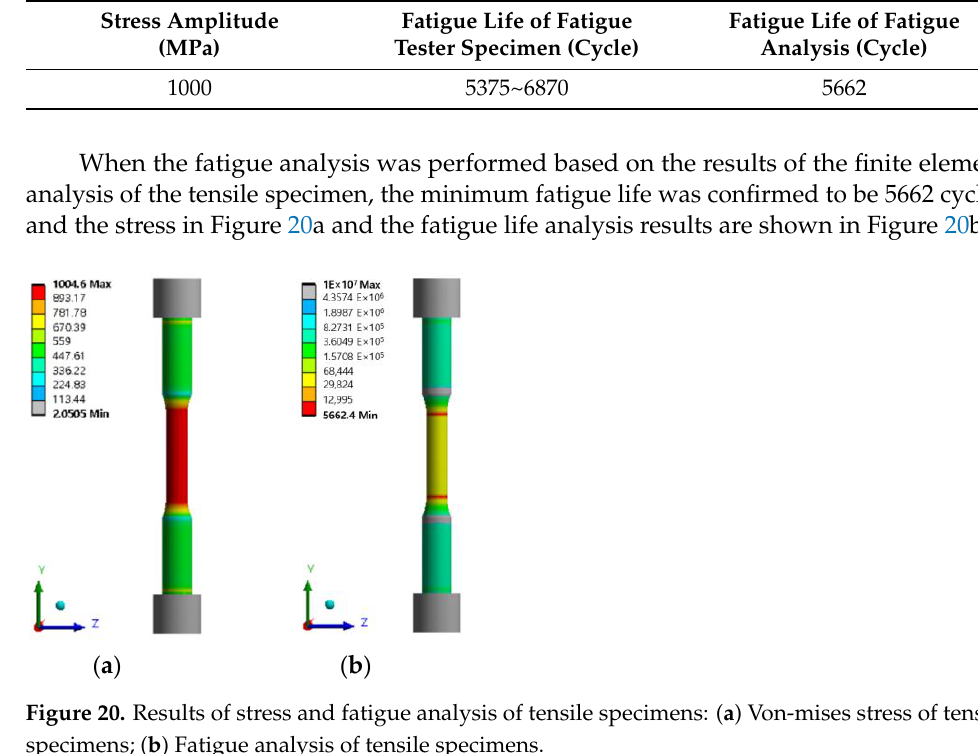
Table 8. Comparison of fatigue test specimens and analysis results.